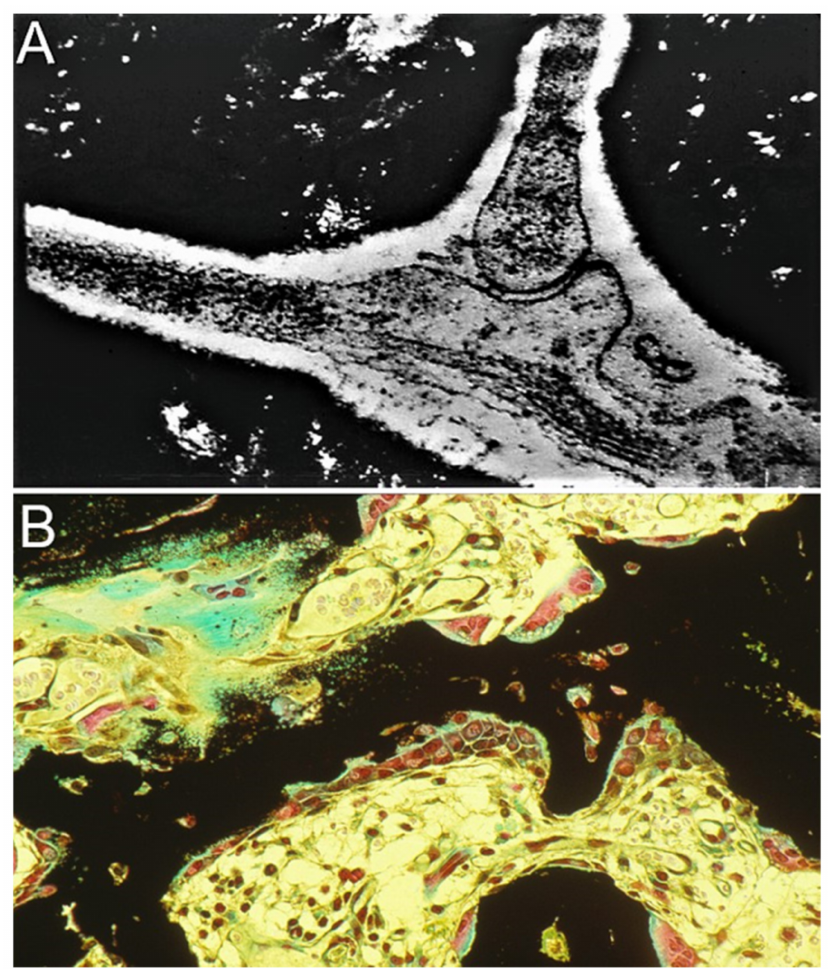
Figure 3. Bone cells functioning in concert in developing and mature bone. Trichrome hematoxylin and eosin stain with silver nitrate showing calcified tissue (black) and unmineralized osteoid (green). ( A ) Bone cells form a functional syncytium in which gap junction channels provide direct intercellular communication pathways for electrical currents, small molecules, and ions, and facilitate the func- tioning of osteocytes in concert in mature bone to respond to metabolic requirements and mechanical strain. ( B ) Coupled osteoblast and osteoclast remodeling of trabecular bone in an experimental model of endochondral bone formation, resulting in mature trabeculae (40 × ). Adapted with permission from Ref. [5]. 1988, Calcified Tissue International